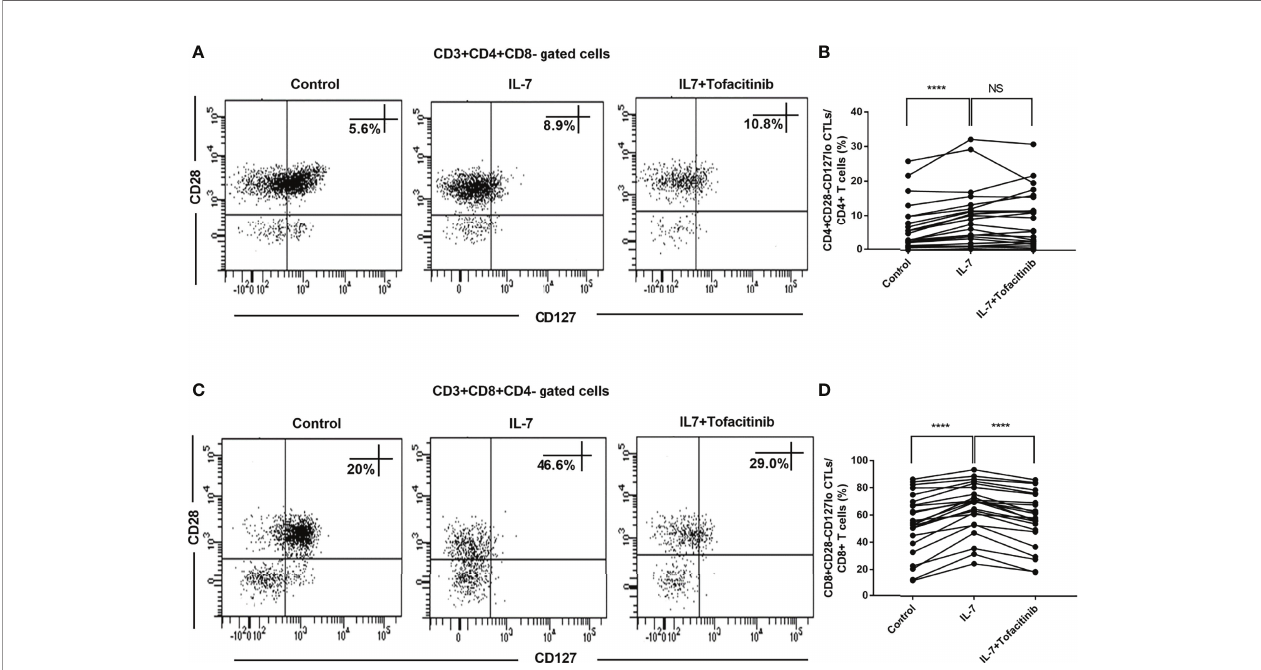
FIGURE 5 | IL-7 induced elevated levels of CD8+CD28-CD127lo CTLs inhibited by JAK inhibitor in IgG4-RD patients. PBMCs from IgG4-RD patients (n = 23) were cultured with 50 ng/mL IL-7 in the presence or absence of 150 nM tofacitinib for 4 days. (A, C) Representative dot plots of fl ow cytometry analysis. CD4+CD28- CD127lo and CD8+CD28-CD127lo CTL percentages in CD4 and CD8 T cells were shown. CD127 was gated according to fl uorescence minus one (FMO) control of CD127. (B, D) The percentages of CD4+CD28-CD127lo CTLs and CD8+CD28-CD127lo CTLs in IgG4-RD patients were compared between IL-7-treated and untreated samples, and between IL-7-treated and IL-7 plus tofacitinib samples as well. The paired two-tailed Student ’ s t-test was used to compare two groups. **** P < 0.0001; NS, not signi fi